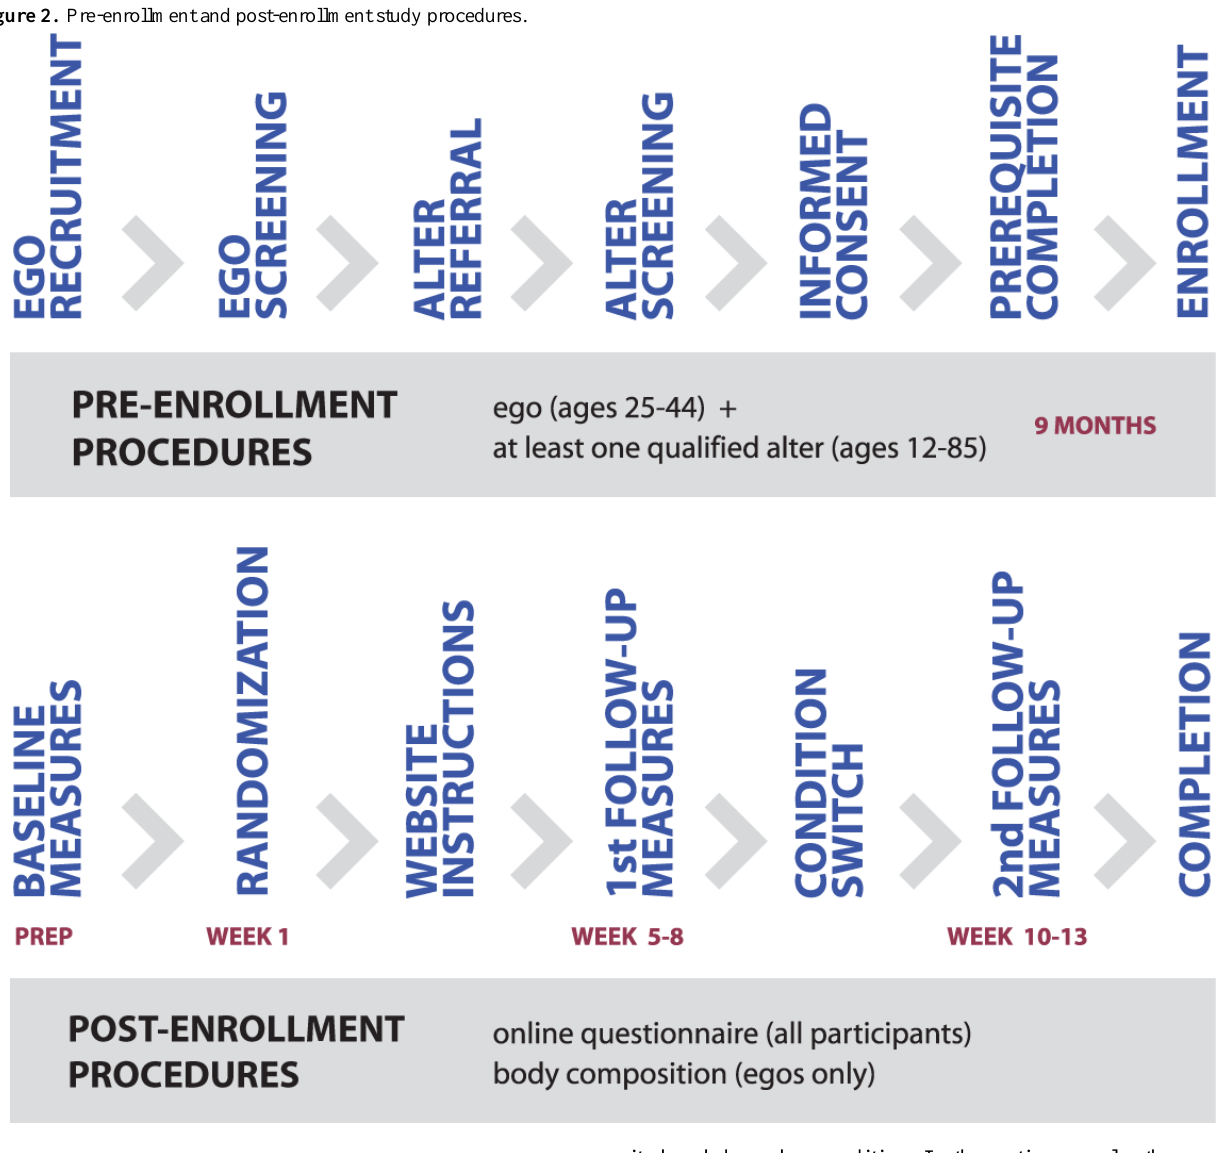
Figure 2. Pre-enrollment and post-enrollment study